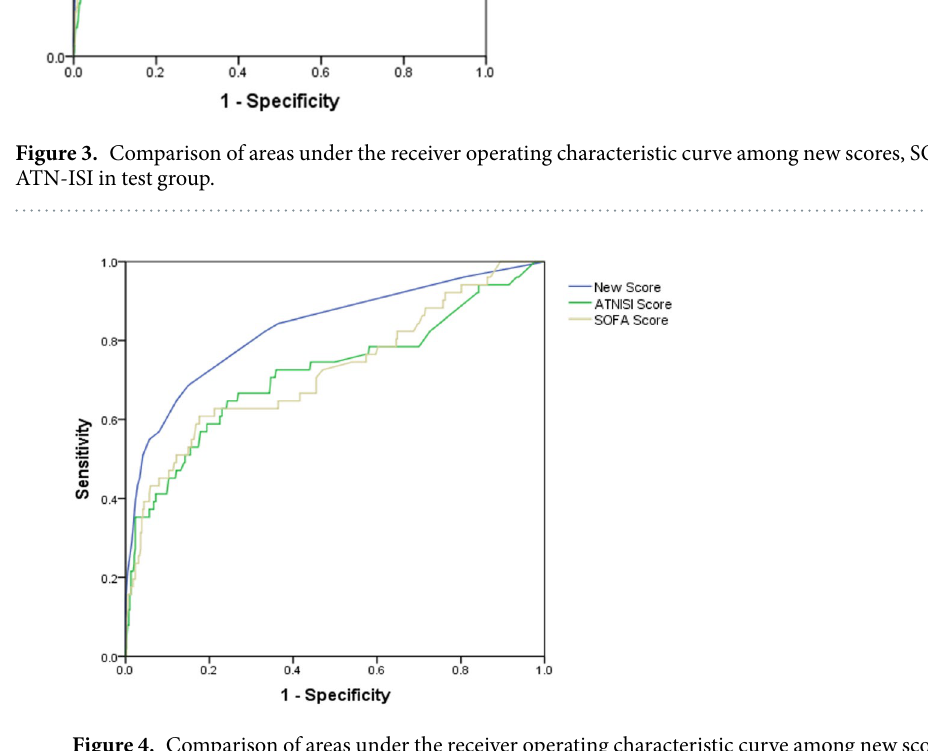
Figure 4. Comparison of areas under the receiver operating characteristic curve among new scores, SOFA and ATN-ISI in validation group.